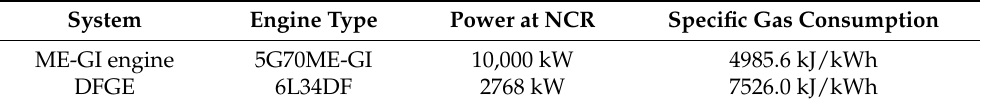
Table 3. Engine specifications.